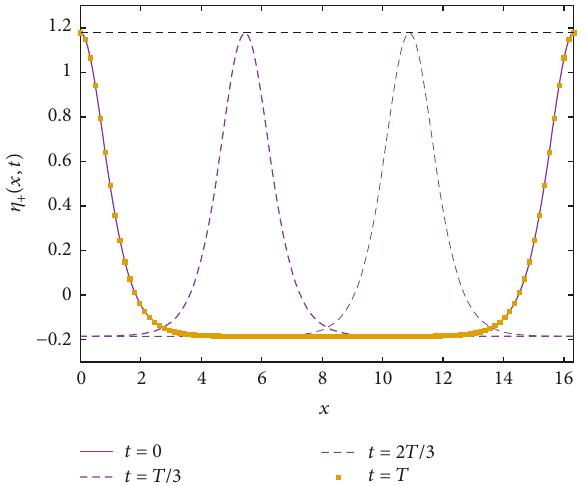
Figure 13: Time evolution of the superposition solution 𝜂 + (𝑥,𝑡) for 𝛼 = 𝛽 = 0.3 and 𝑚 = 0.99 obtained in numerical simulations. Profiles of the wave at 𝑡 = 0, 𝑇/3, 2𝑇/3, 𝑇 are shown, where 𝑇 is the period. The 𝑥 interval is equal to the wavelength.